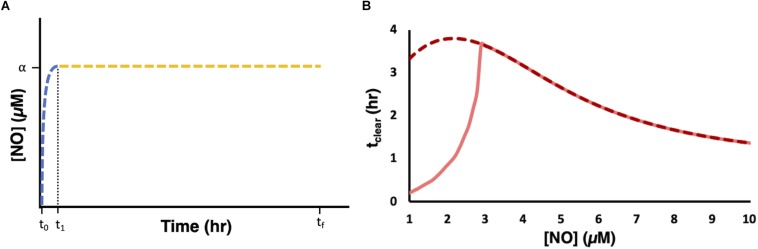
Designing and implementing delivery schemes to maintain steady state [NO]. (A) For a desired NO concentration α and payload ω, a bolus delivery was introduced at t0 such that the [NO] profile (blue dashed line) peaked at [NO] = α at t1. At t1 a dosing regime was implemented to maintain d[NO]/dt = 0 and [NO] = α up until tf (yellow dashed line), at which point the payload ω was exhausted. (B) Steady state dosing regimes were simulated at [NO] between 1 and 10 μM for a payload of 24 μmol and tclear was measured (dark red dashed line). The light shaded solid red line represent the relationship between tclear and [NO] when implementing a step function delivery approximation. All simulations were performed using the optimal parameter set (ER = 1, minimum SSR, 1 set).